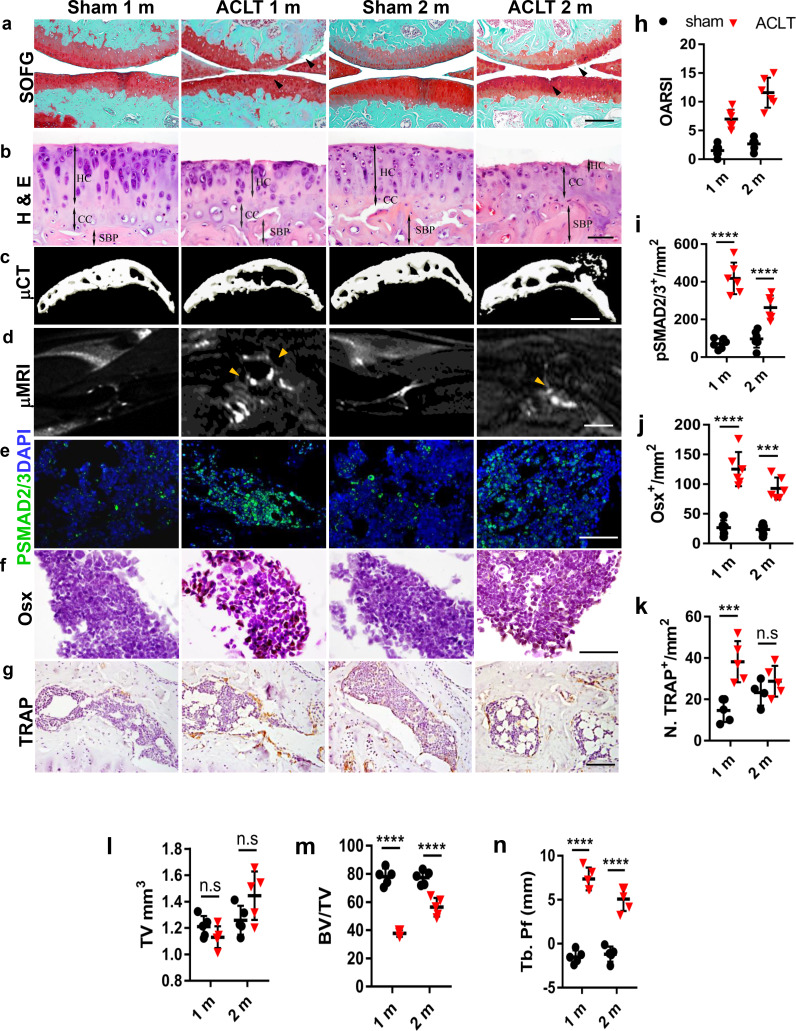
Aberrant subchondral bone remodeling after ACLT.(a–g) Parameters of subchondral bone remodeling in OA progression. Safranin Orange and fast green staining (a), H and E staining (b), μCT 3D reconstruction (c), representatives of T2 weighted fat suppression μMRI image showing bone marrow lesion (yellow arrows) (d), pSMAD2/3 (green) immunostaining (e) and Osterix immunostaining (f) and TRAP staining (g) of murine tibial subchondral bone after sham or ACLT surgery at 1 m and 2 m. Scale bars, 500 μm (a, b), 2 mm (c), 5 mm (d), 10 μm (e–g), n = 6 per time point. (h–n) Quantitative analysis of OARSI score (h), number of pSMAD2/3+ cells per mm2 (i), number of Osterix+ cells per mm2 (j), number of TRAP+ cells per mm2 (k), TV (l), BV/TV (g) and Tb Pf (n) after sham or ACLT in 1 m, n = 6 per time point. *p<0.01, ***p<0.001, ****p<0.0001 compared with the sham-operated group or healthy donors at different time points. Statistical significance was determined by multifactorial ANOVA WITH BONFERRONI POST HOC TEST (h–n) and all data are shown as scattered plots with means ± standard deviations.